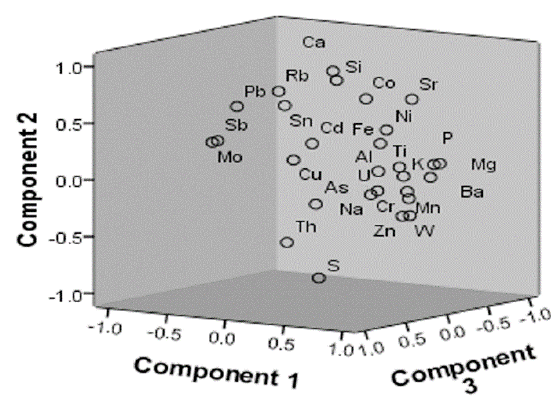
Figure 3. Loaded characteristics for PC1, PC2, and PC3 resulting from principal component analysis (PCA) of multi-elemental analyses of the fish skin in different stations of the southern coasts of the Caspian Sea